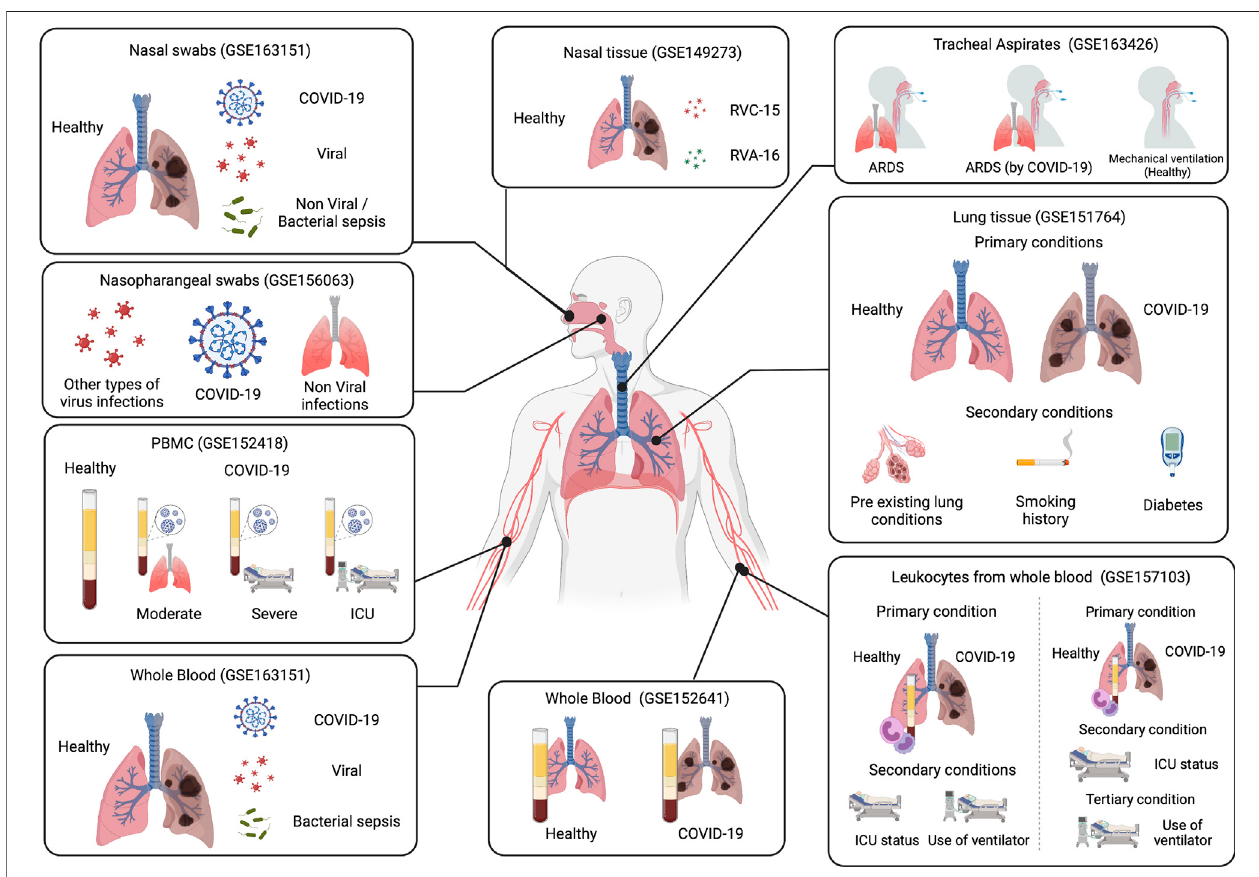
FIGURE 2 | Summary of the different types of analysis carried out (BioRender (2021). Created, 2021).